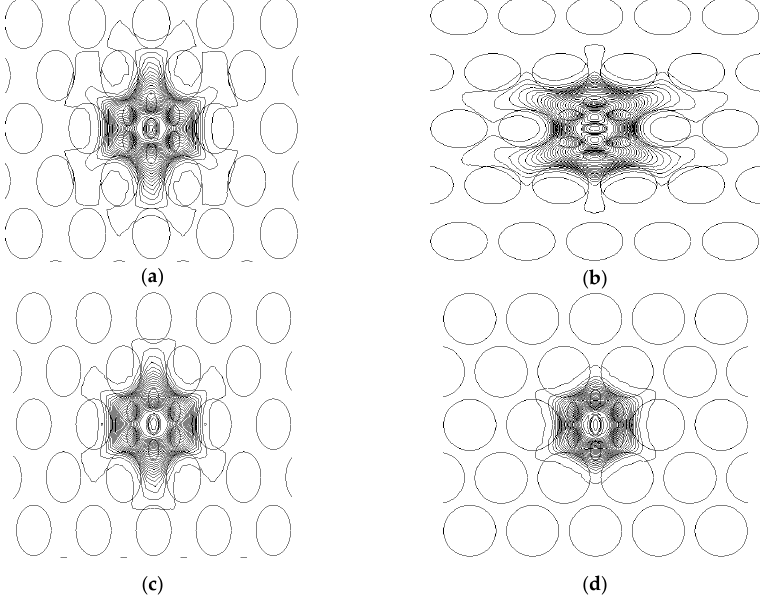
Figure 3 . The electric field distribution of the x -polirized LP 01 mode of ( a ) V-PCF and ( b ) H-PCF, where η = 0.7 and the core holes are filled with refractive index of 1.33. The field profile of V-PCF where, supplementary holes are filled with ( c ) n = 1.366, η = 0.7, and ( d ) n = 1.366, η = 1 (for all figures the wavelenght is fixed at λ = 1 µm) .